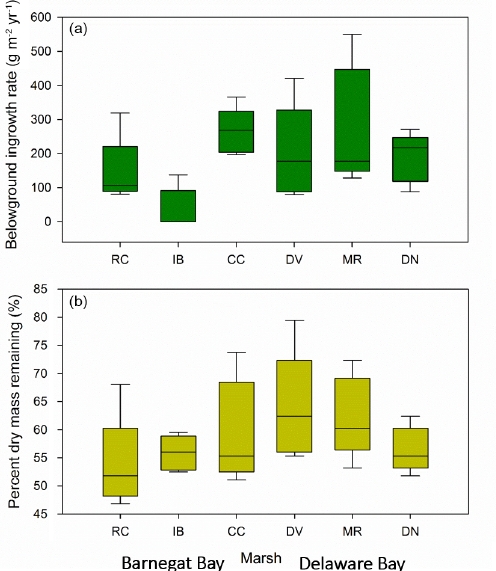
biomass was over 6 times greater in MR than in RC and IB in Barnegat Bay (marsh[estuary]: F 1 , 4 = 8.13, p = 0.0021; Table 2). In Barnegat Bay, live aboveground biomass